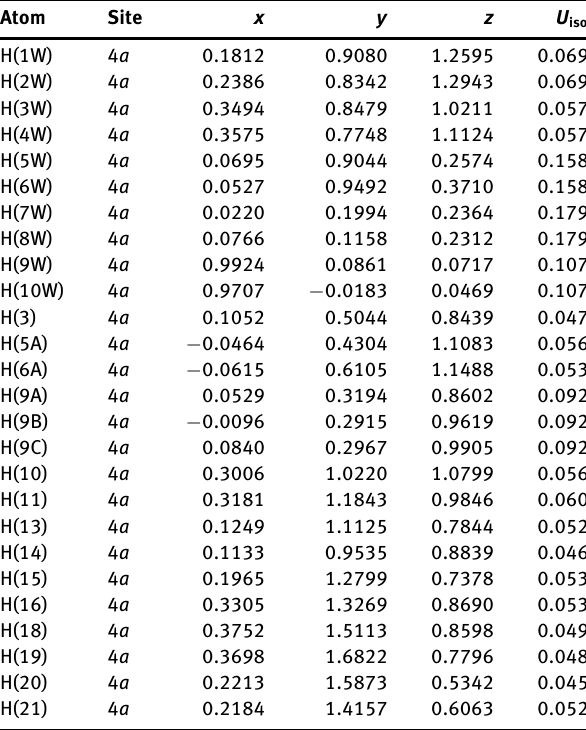
Table 2: Fractional atomic coordinates and isotropic or equivalent isotropic displacement parameters (Å 2